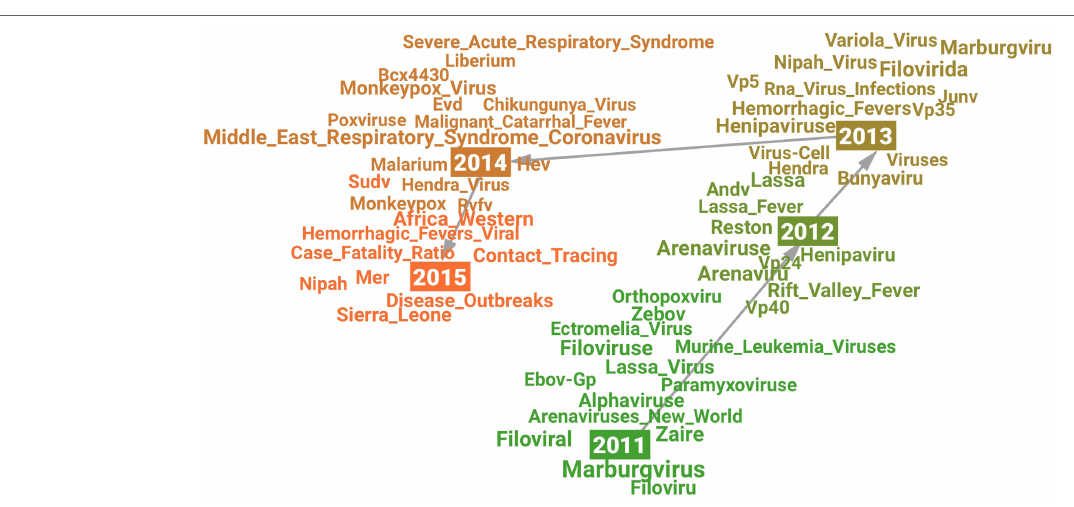
Frontiers in Research Metrics and Analytics |